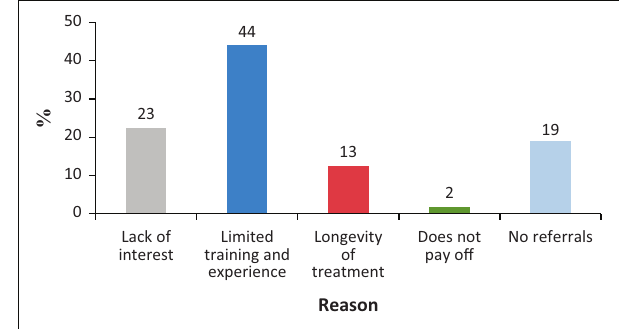
Lack of Limited Longevity Does not interest training and of pay off experience treatment Reason FIGURE 4: What prevents speech-language therapists from treating cleft lip/ palate/craniofacial deformities patients?